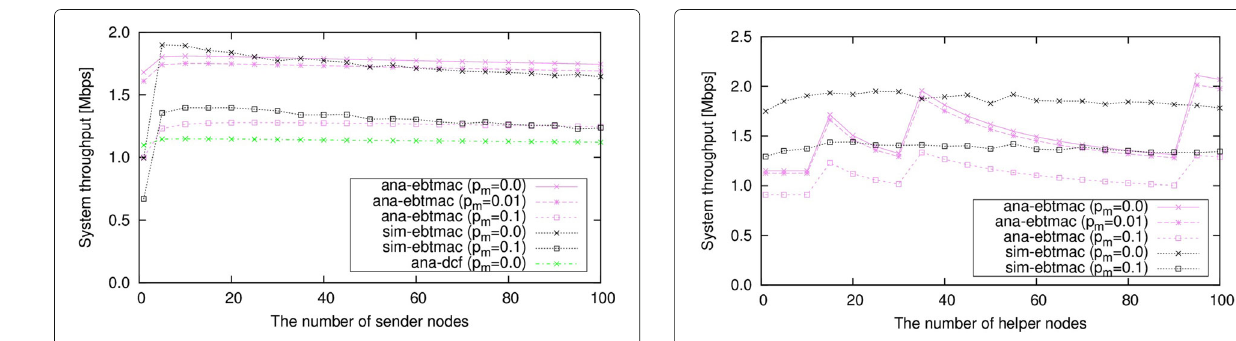
Fig. 9 Throughput performance as a function of N s Fig. 11 Throughput performance as a function of N